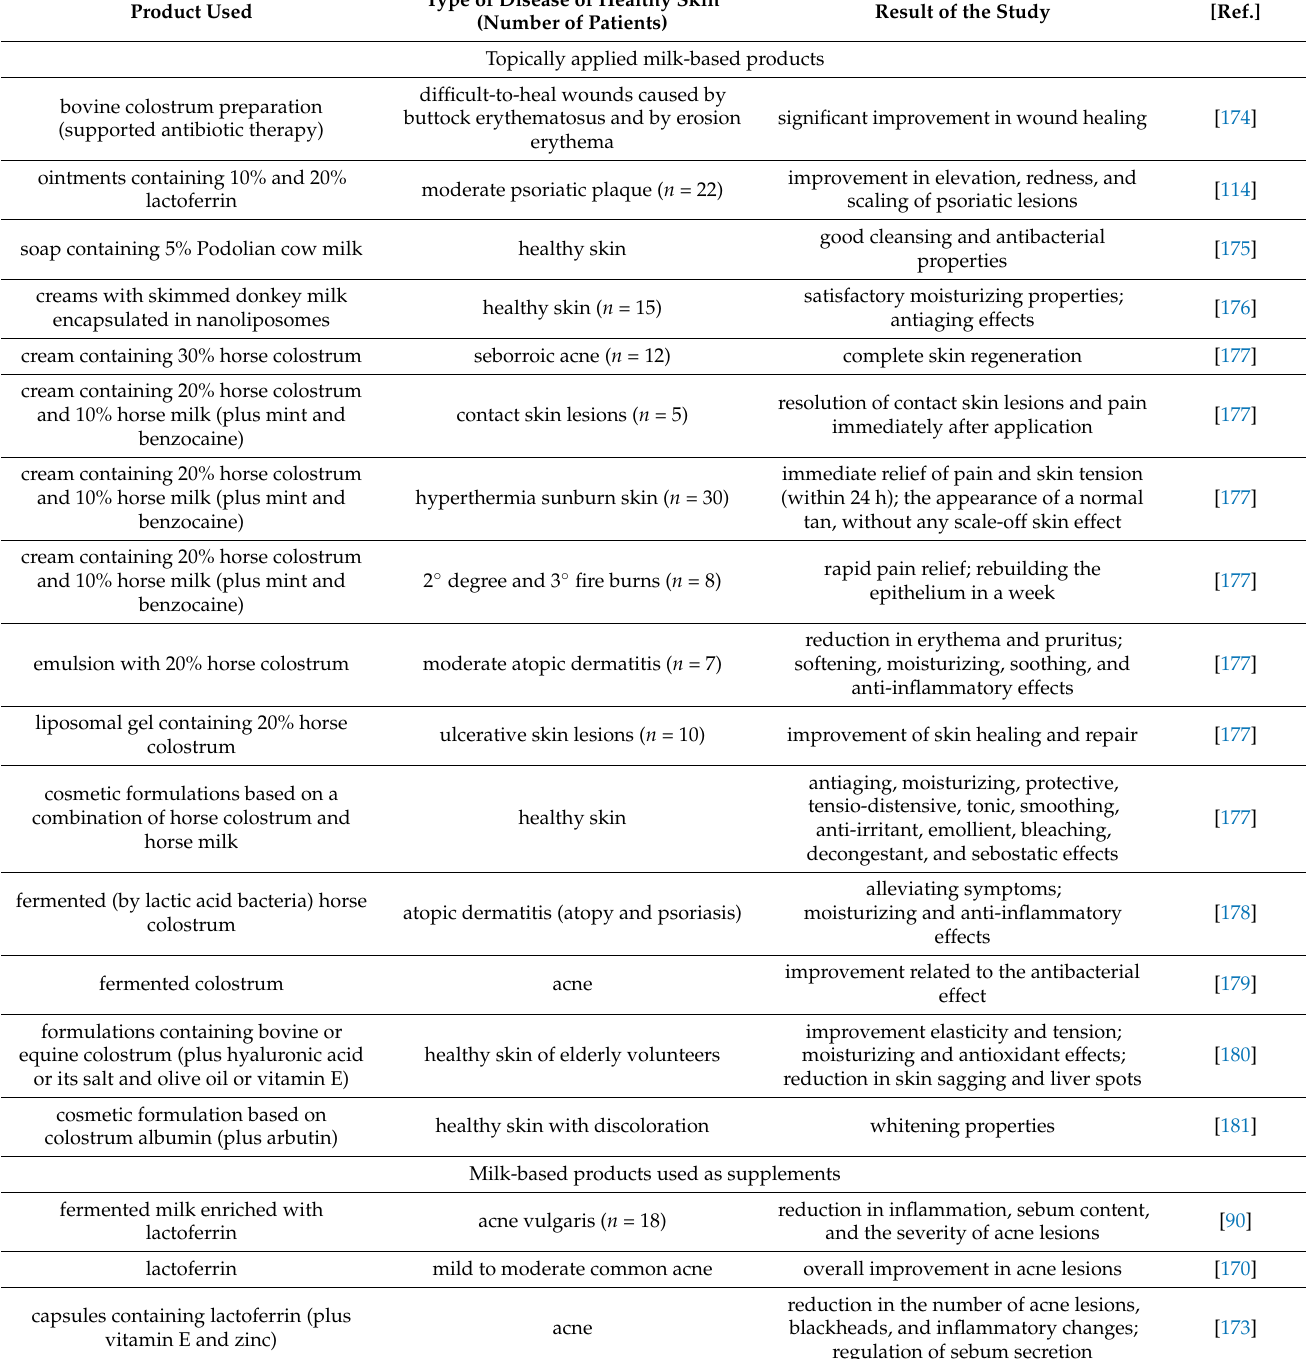
Table 4. Clinical studies with milk-or colostrum-based